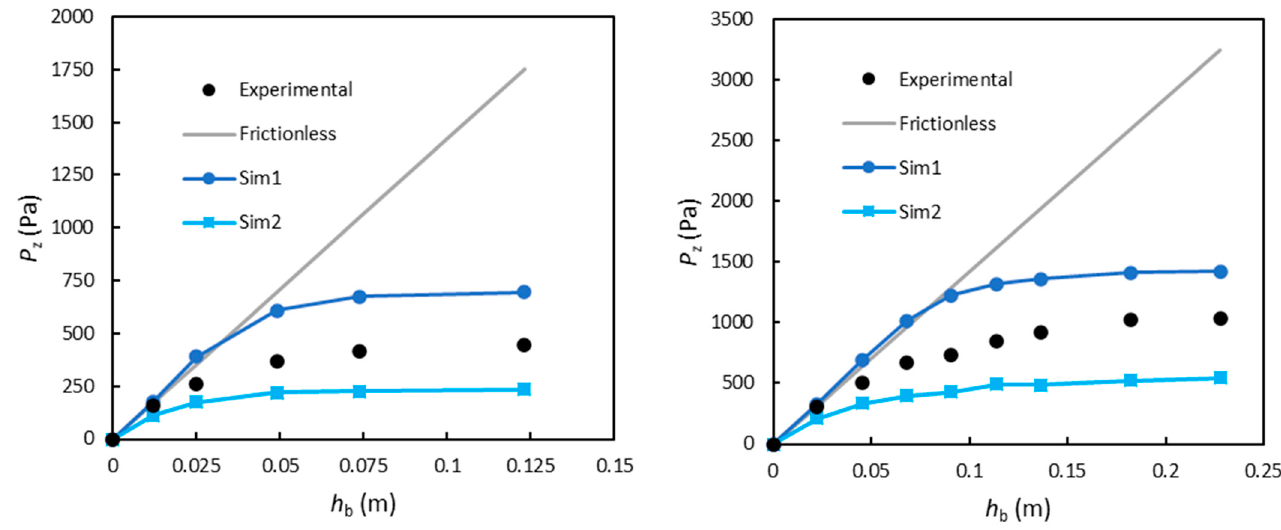
Figure 3. Solids pressure at different bed depths: 1.7 mm glass particles in the 28 mm column ( left ) and 5 mm glass particles in the 61 mm column ( right ).